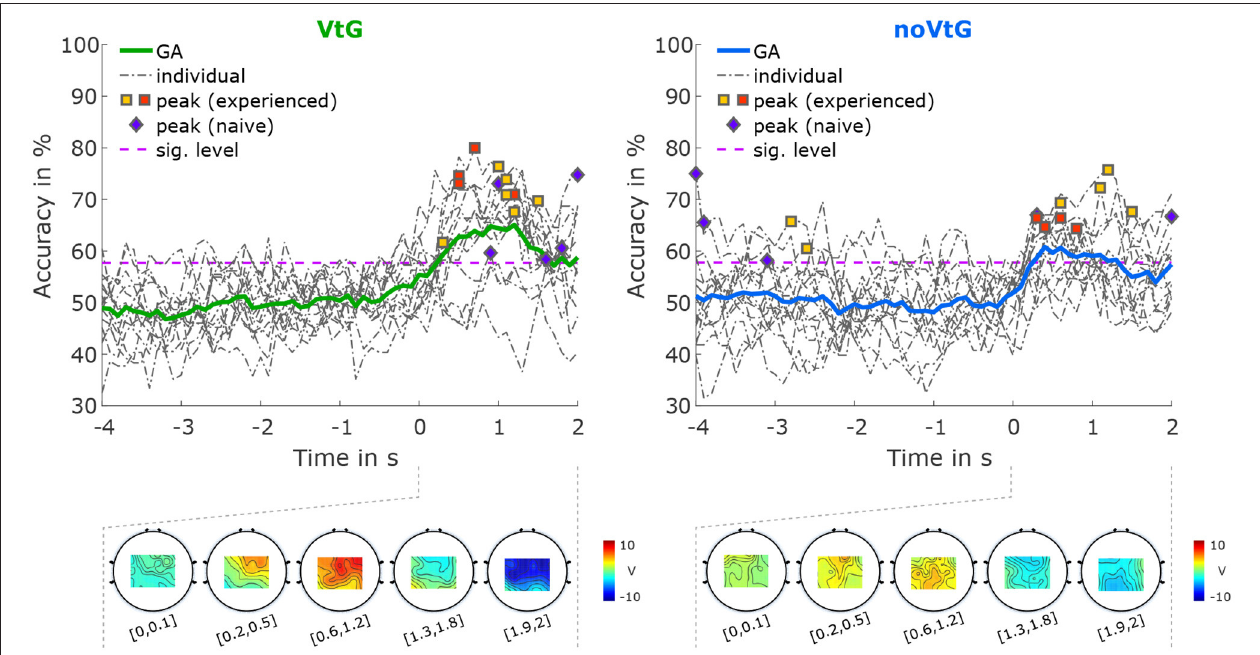
FIGURE 5 | Classification results for direction right vs. direction up, based on amplitude features. The grand-average accuracies are depicted as thick solid lines, in green for condition VtG, and in blue for condition noVtG. Single-subject accuracies are represented by dash-dotted dark gray lines, and the individual peak accuracies are marked with squares for MI experienced participants, and diamonds for MI naïve participants, with the same color coding as in Figure 4 . Below the accuracy plots, the activation patterns are presented for selected time intervals during the MI